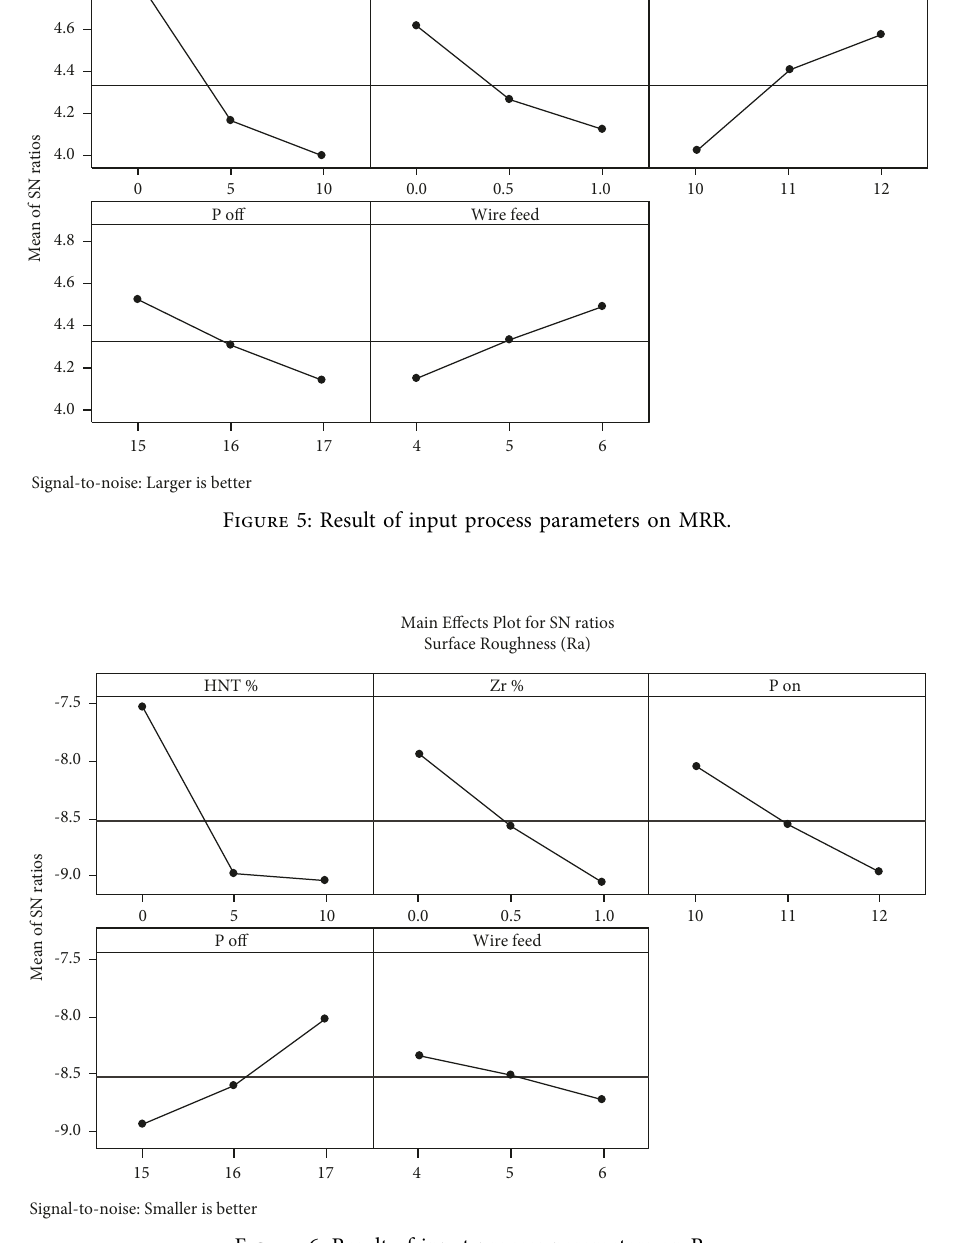
Figure 6: Result of input process parameters on